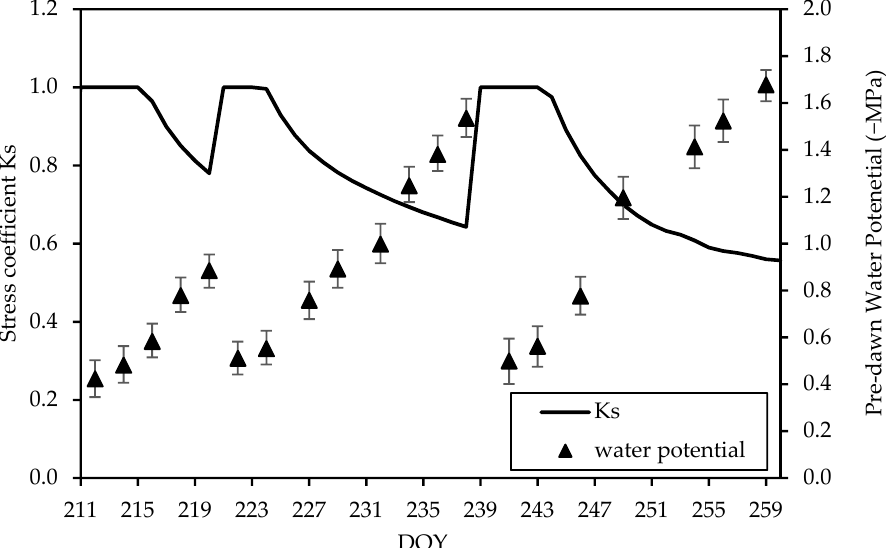
Figure 3. Stress coefficients (Ks) during the experimental period. The statistical standard error is shown in bars.